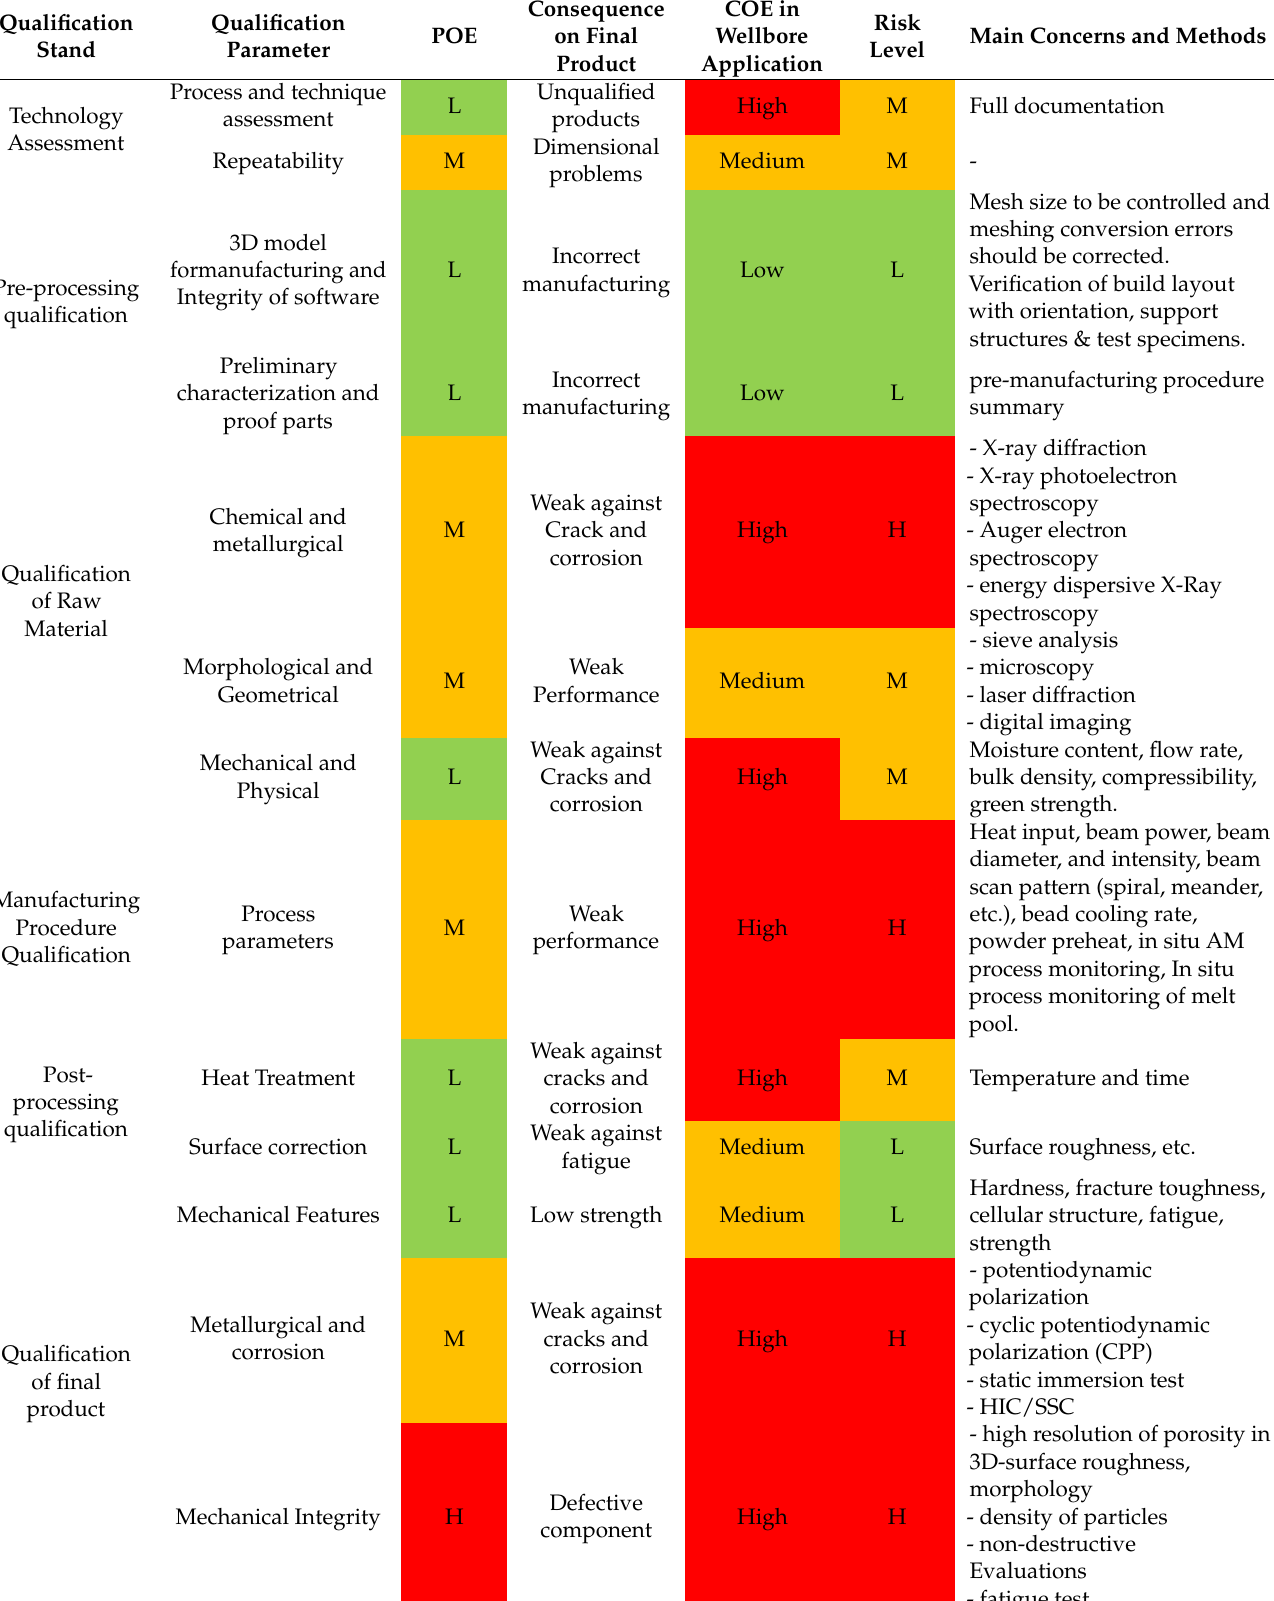
Table 8. Result of risk assessment for qualification of additively manufactured stainless steel